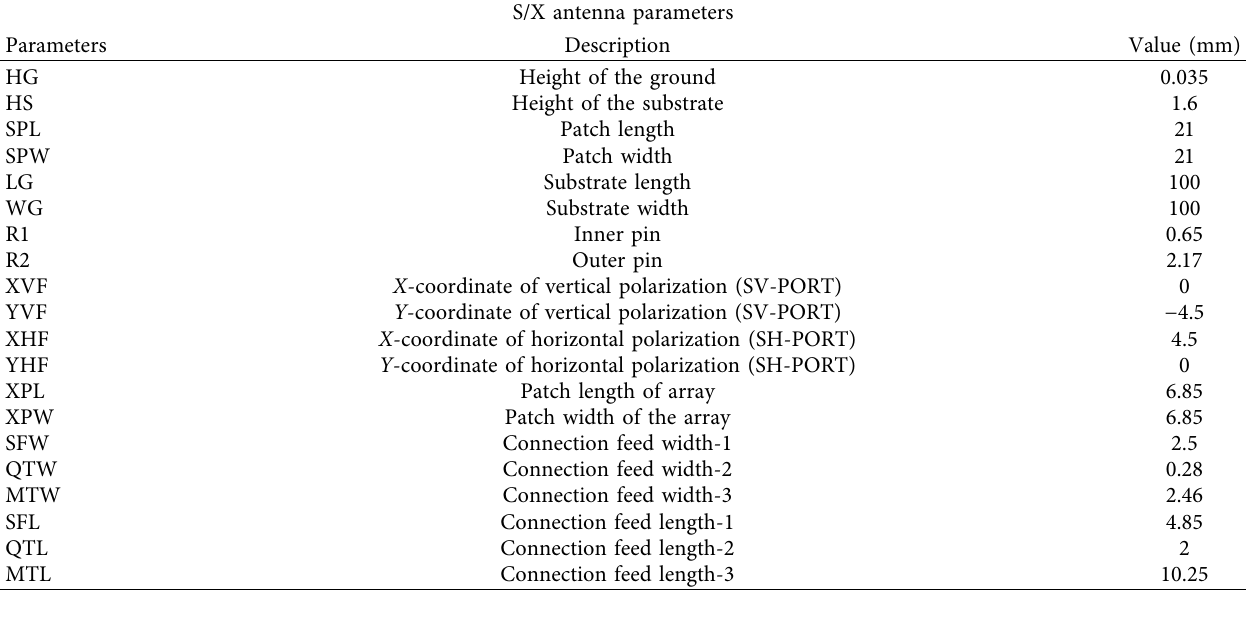
Table 3: Dimensions of the antenna design prototype of the S/X antenna.